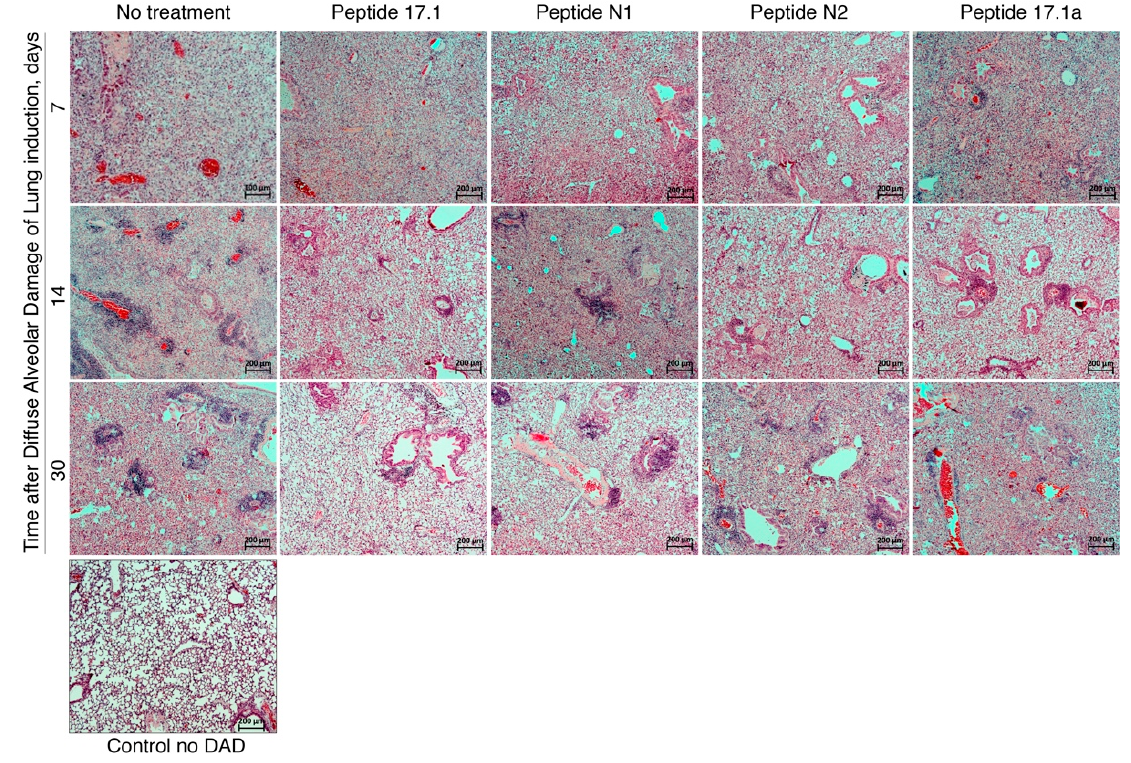
Figure 7. Fragments of the left lung lobe of male ICR mice, intact, on the 7th, 14th and 30th days after induction of DAD in presence of peptides 17.1, N1, N2 and 17.1A or without treatment. Table 1. Scoring scale table of peribronchial and perivascular infiltration with the mononuclear cells, infiltration of alveolar walls and ducts with the mononuclear cells and sites of pulmonary collapse of male ICR mice on the 7th, 14th and 30th days after induction of DAD in presence of peptides 17.1, N1, N2 and 17.1A or without treatment ( n = 6 for each group).